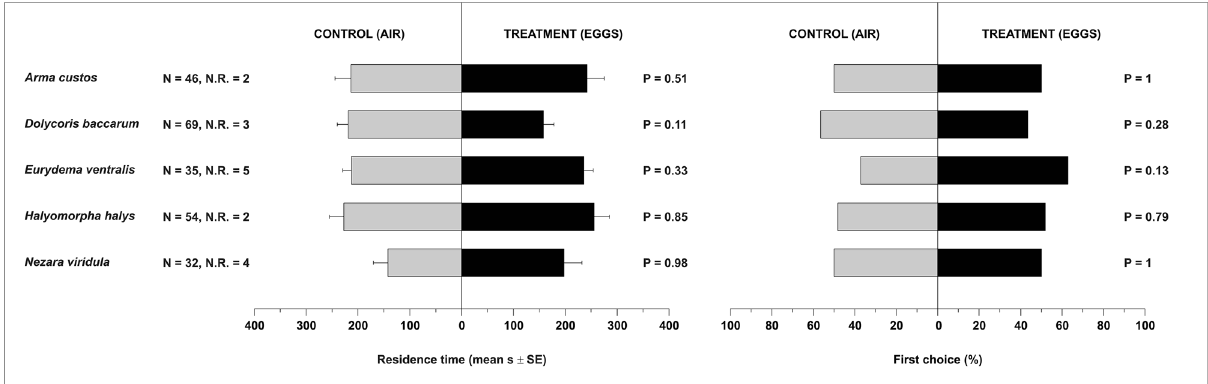
Figure 3. Residence time (means ± SE) and first choice (%) of Trissolcus mitsukurii females in Y-tube olfactometer exposed to odours from stink bug eggs. Treatments consisted of volatiles from eggs of Arma custos